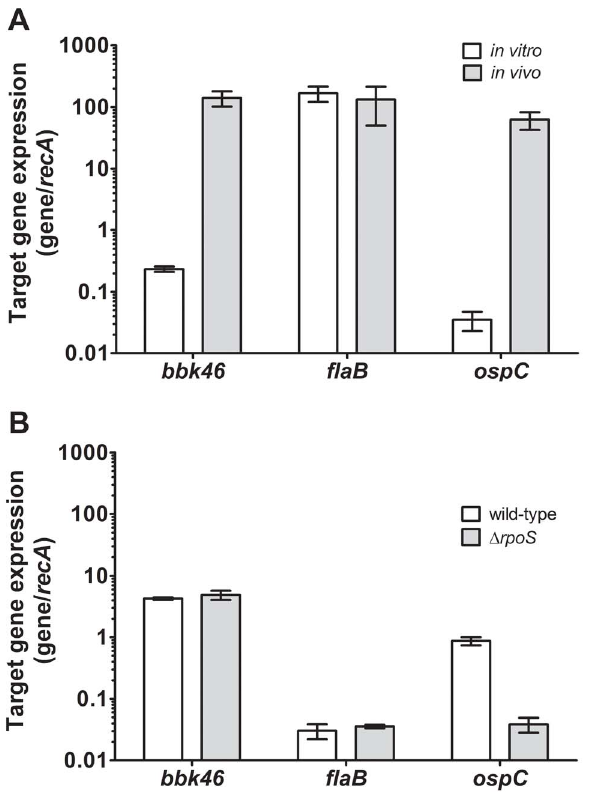
Figure 3. Expression of the bbk46 gene is upregulated during murine infection and is RpoS-independent. Total RNA was isolated from bladder tissue collected from (A) mice infected with 1 6 10 5 wild-type B. burgdorferi three weeks post-inoculation ( in vivo , gray bars) and from log phase in vitro grown spirochetes ( in vitro , white bars) or (B) stationary phase temperature-shifted stationary phase in vitro grown wild-type (white bars) or D rpoS (gray bars) B. burgdorferi . RNA was reverse transcribed to cDNA using random hexamer primers. The expression of bbk46 , flaB and ospC were quantified using quantitative reverse transcription polymerase chain reaction (qRT-PCR) and a standard curve analysis method. The mRNA levels of the bbk46, flaB and ospC gene transcripts were normalized to that of the constitutive recA gene. The data are expressed as the gene transcript/ recA transcript. The data represent the average of triplicate qRT-PCR analyses of 3 biological replicates. Error bars represent the standard deviation from the